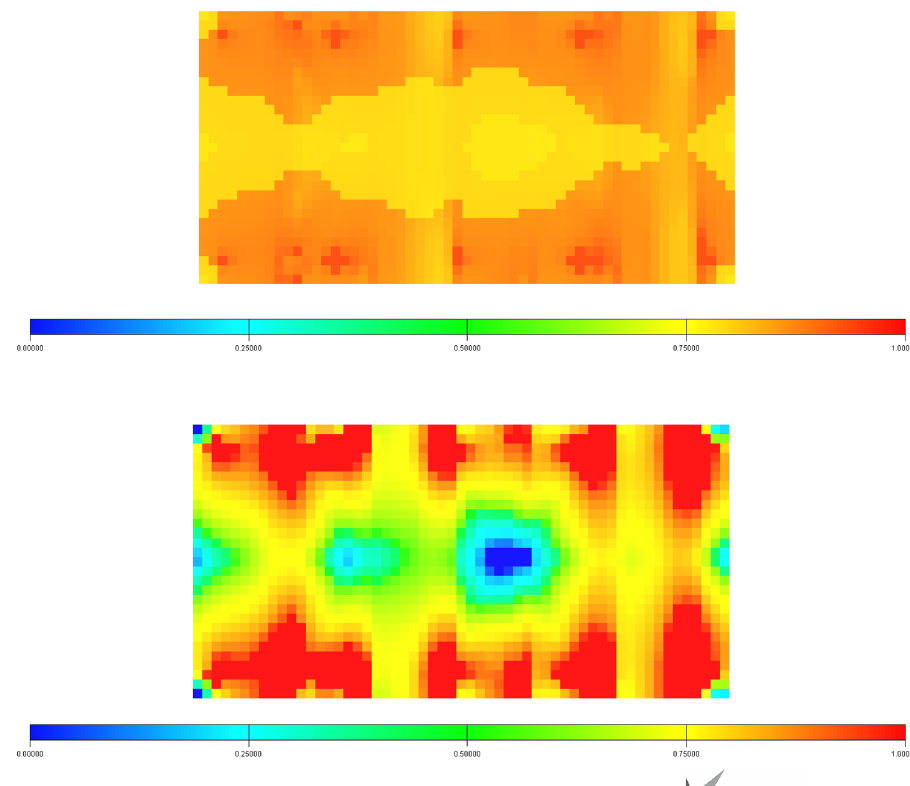
Fig. 7 Flow field strength distribution at the reservoir bot- tom considering parameters as